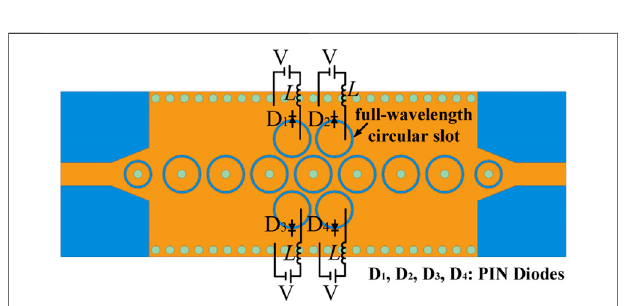
FIGURE 5 | Schematic con fi guration of the proposed SSPP-based BPF with the switchable notch band.